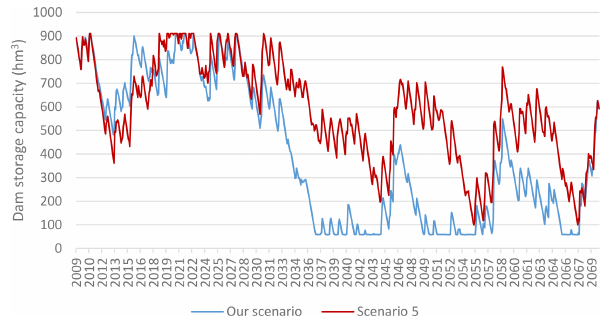
Figure 5. Comparison of Zapotillo dam’s behavior in scenario 5 (UNOPS, 2017b) and our scenario, which includes climate change and future water demand.